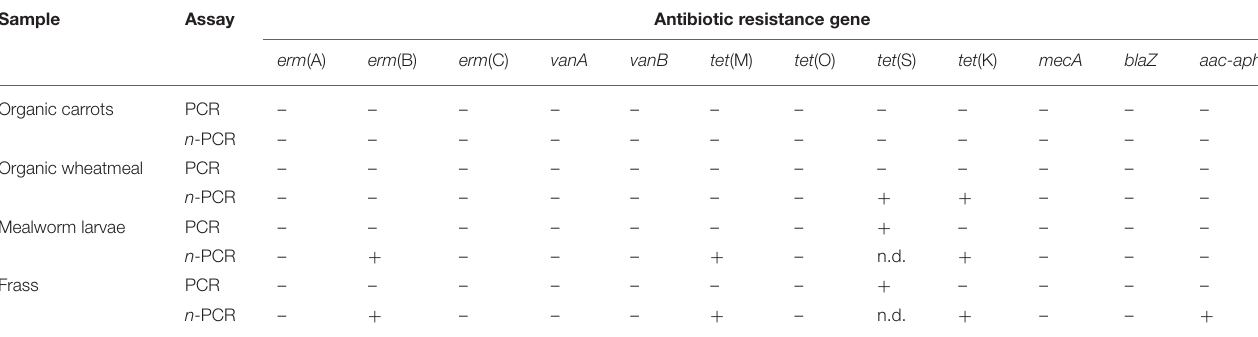
TABLE 4 | Results of PCR and nested PCR amplification of AR genes in samples of carrots and wheatmeal used as feed, and fresh mealworm larvae and frass of the three pooled rearing batches. Sample